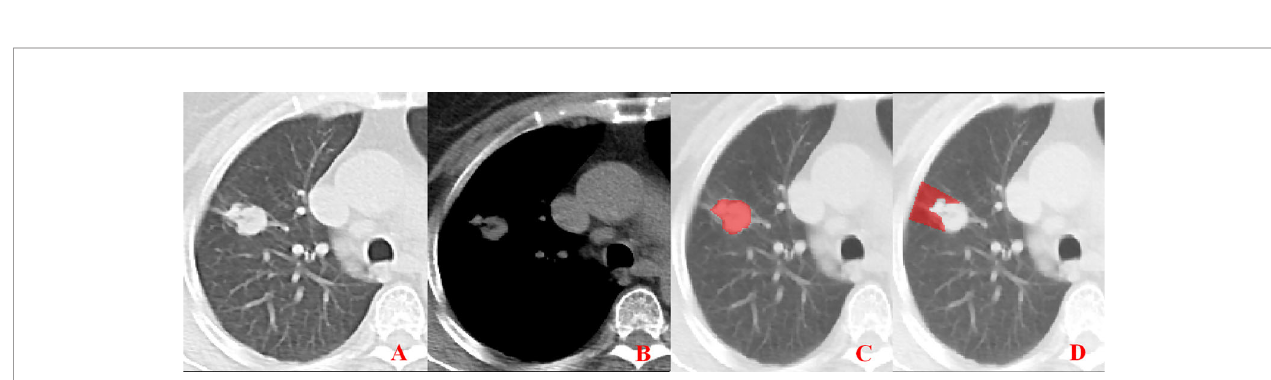
FIGURE 1 | Representative image showing no pleural involvement. (A, B) No pleural involvement is seen in either the lung window or mediastinal window images. (C, D) ROI delineation of the primary tumor and nearby pleura.